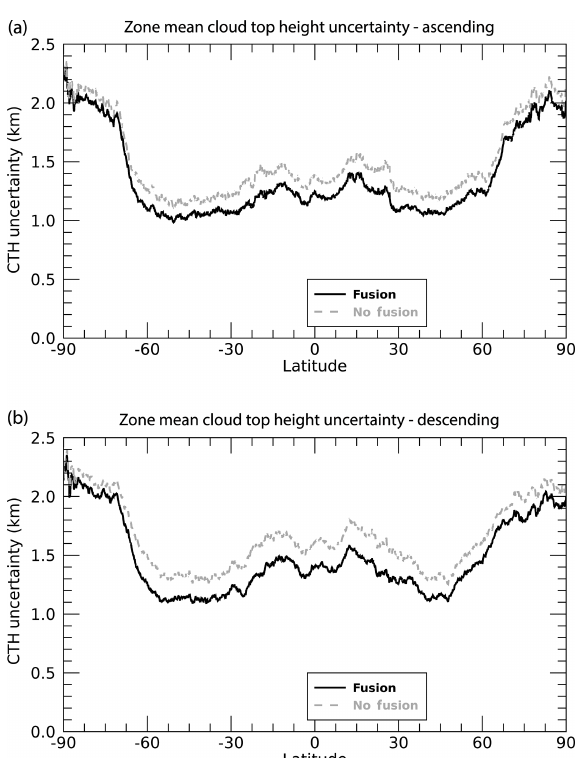
Figure 9. Zonal mean ice cloud top height uncertainty estimated from ACHA’s optimal estimation algorithm for S-NPP VIIRS com- puted from 2 weeks of global level-2b data in 2018. Panel (a) shows the ascending track and panel (b) shows the descending track.